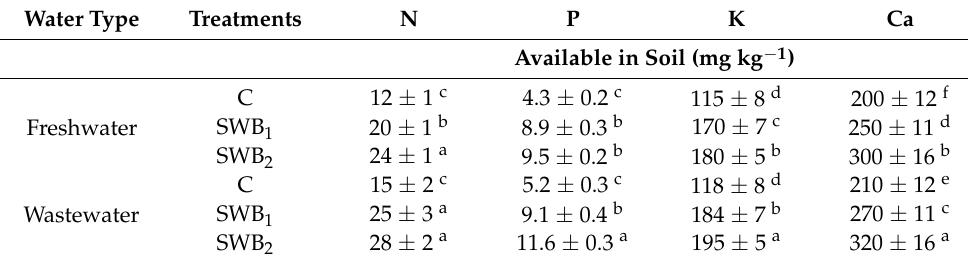
Table 5. Effect of shrimp-waste-derived biochar (SWB) rates on nitrogen (N), phosphorous (P), potassium (K), and calcium (Ca) availability in soil. C, SWB 1 , and SWB 2 are 0, 1, and 2% ( w / w ) of biochar. Means ( ± SD, n = 5) with different letters indicate significant differences.